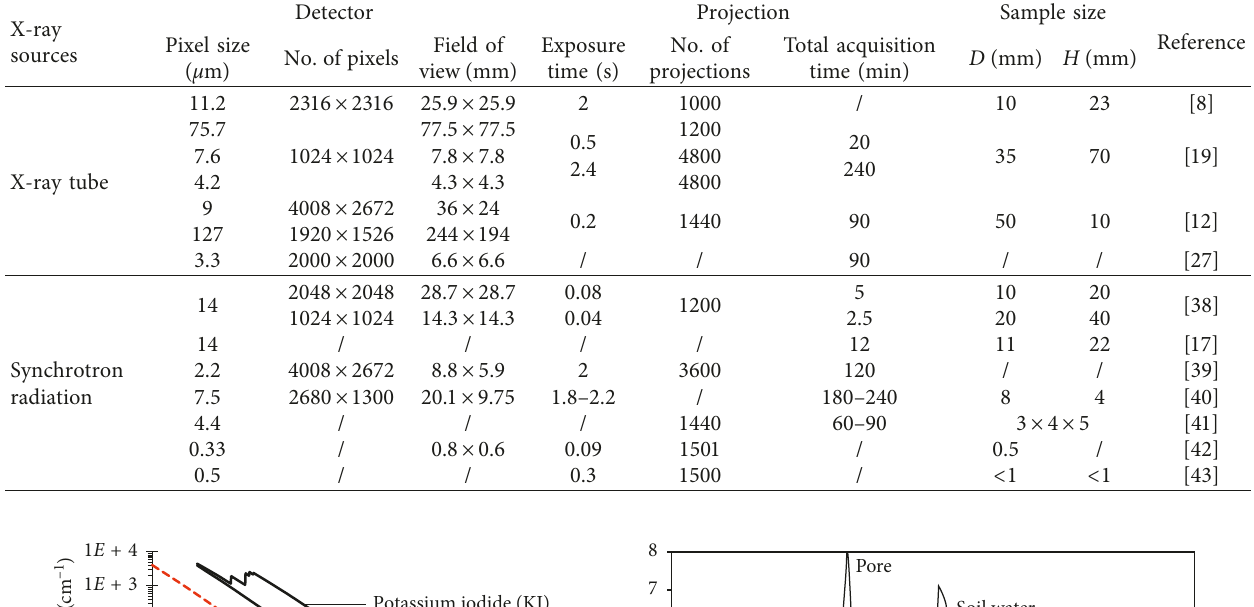
Table 1: Main parameters of recent X-ray μ -CT tests on soils in the literature.